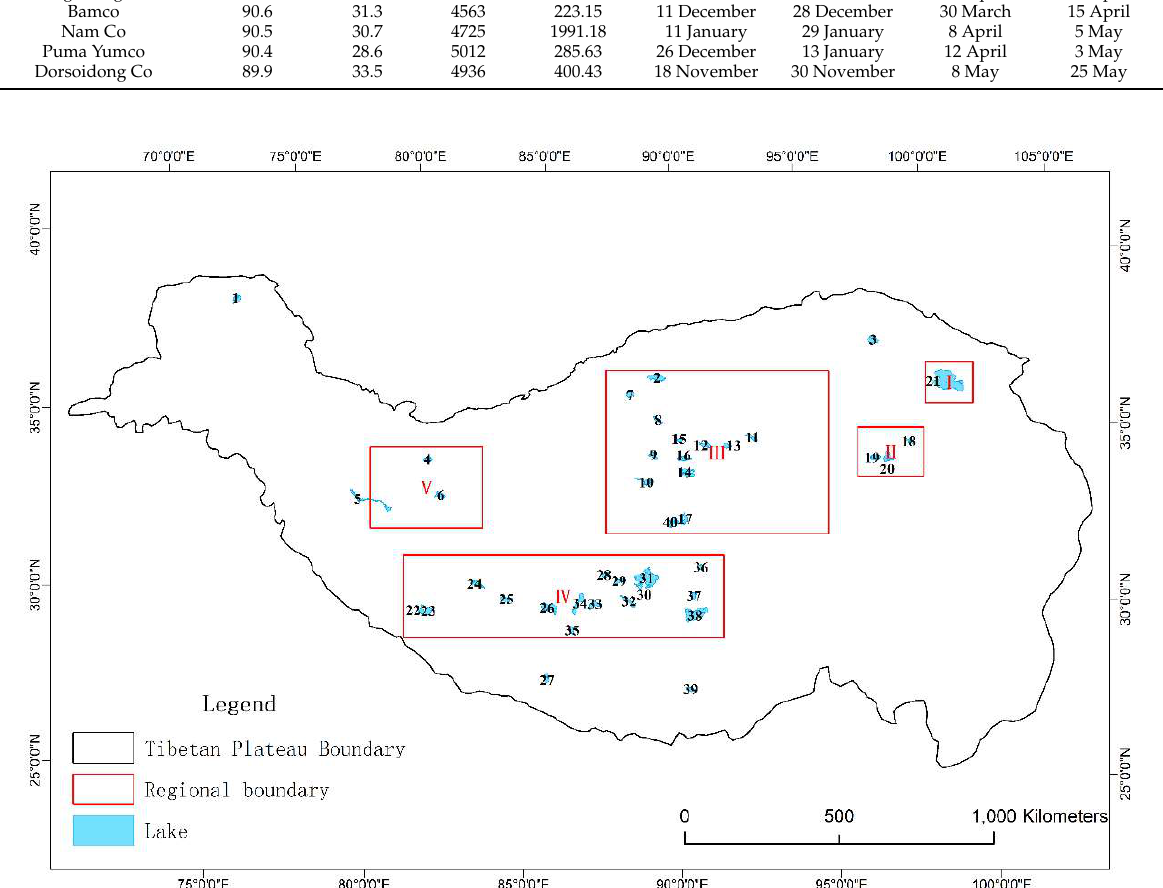
Figure 1. Distribution of the targeted lakes on Tibetan Plateau, where the black numbers indicate the positions of the lakes, with lake information shown in Table 1.